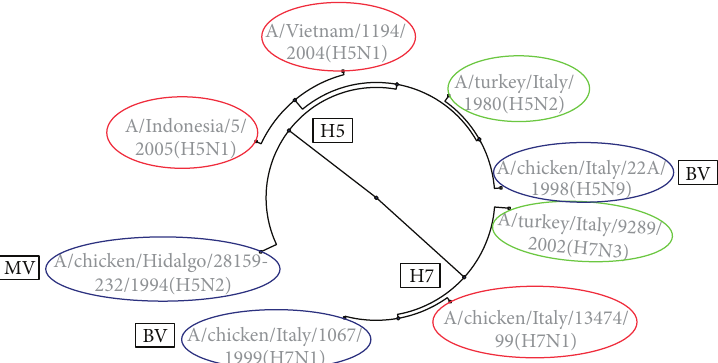
Figure 1: Radial phylogenetic tree showing the relationship between the full-length HA genes of vaccine and serological antigens (MATLAB Software). MV: monovalent vaccine strain, BV: bivalent vaccine strain. Viruses encircled in blue represent vaccine strains, in red represent pseudotype antigen strains, and in green represent HI antigen strains. The amino acid identity of these strains is shown in Figure 4.